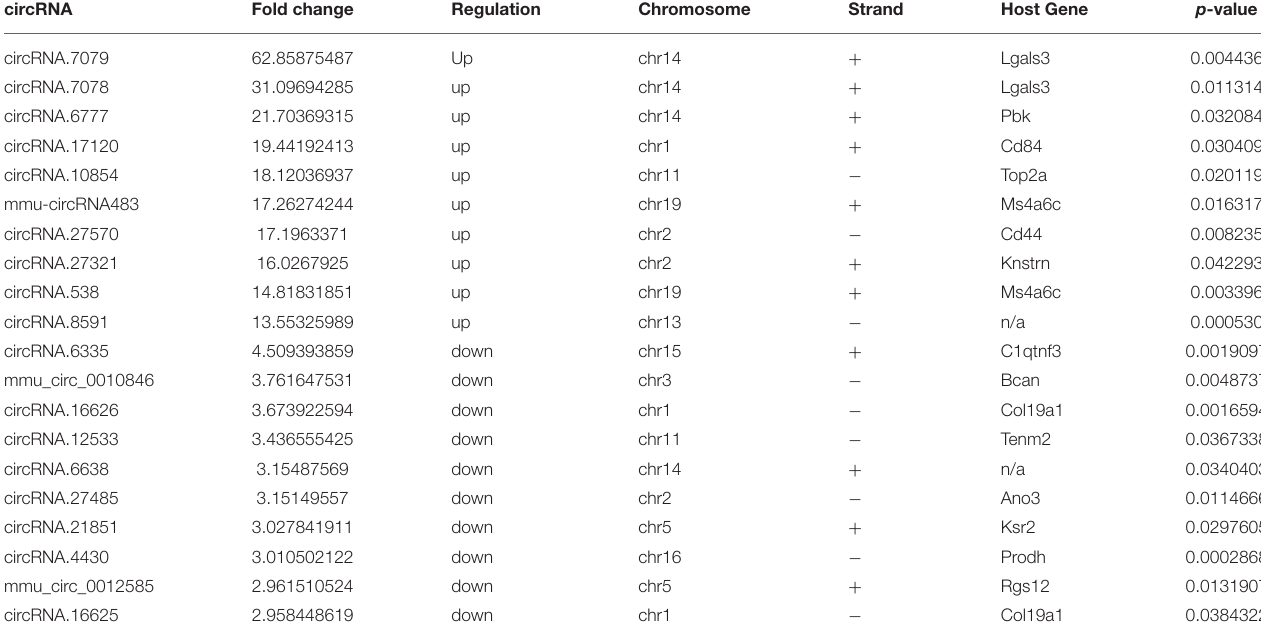
TABLE 1 | The top 20 differentially expressed CircRNAs after spinal cord injury (SCI). circRNA Fold change Regulation Chromosome Strand Host